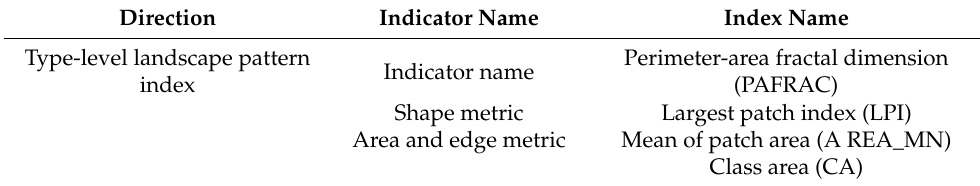
Table 2. Landscape pattern index